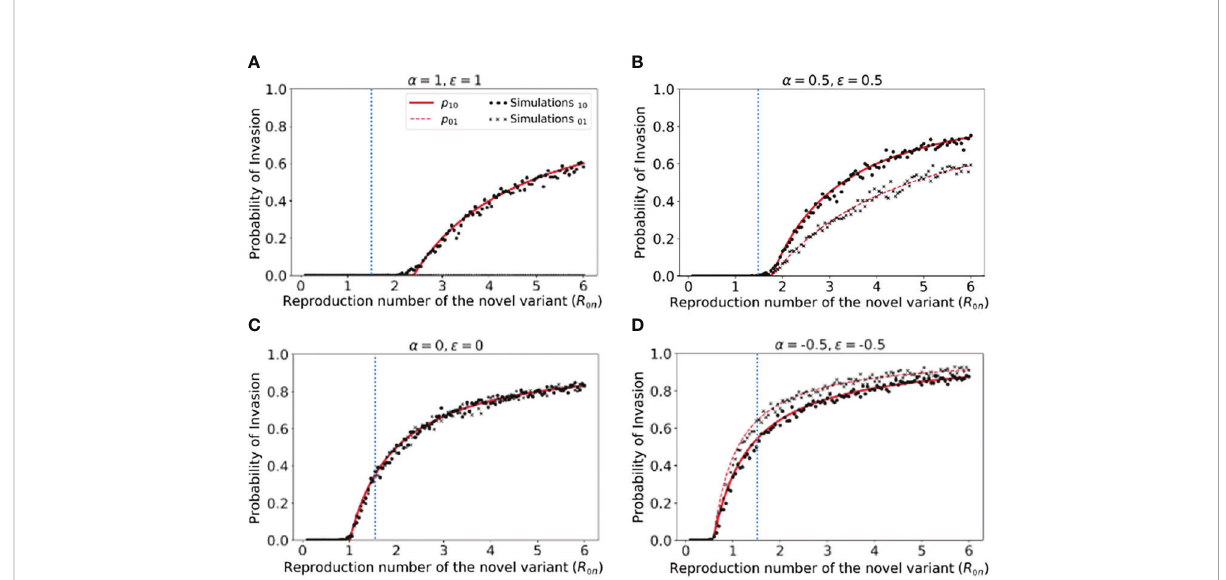
FIGURE 2 Probability of the novel variant invading the host population, starting from the introduction of a single infectious individual. (A) The probability of the novel variant invading under an assumption of perfectly protective cross-reactive immunity ( a = ϵ = 1). Results are shown both for analytic approximations of the invasion probability calculated using system of equations (3) (either starting from a single infected individual who was previously immunologically naïve (red solid) or starting from a single infected individual who was previously infected by the related virus (red dashed)) and for the invasion probability calculated using stochastic simulations (either starting from a single infected individual who was previously immunologically naïve (black dots) or starting from a single infected individual who was previously infected by the related virus (black crosses)). The vertical blue dotted line represents the reproduction number of the previously circulating virus ( R 0 p = 1.5). (B) Analogous results to panel A, but with partial protective cross-reactive immunity ( a = ϵ = 0.5). (C) Analogous results to panel A, but with no cross-reactive immunity ( a = ϵ = 0). (D) Analogous to panel A, but with cross-reactive immunity instead promoting infection with the novel variant ( a = ϵ = -0.5). In the simulations, the probability of invasion was calculated as the proportion of simulations in which the number of simultaneously infected individuals ( I n + I p ) exceeded 15 at any time (analyses for different values of this threshold are shown in Figures S2, S3, with similar results). As in Figure 1, the division of the host population between individuals who were previously immunologically naïve and those who were previously infected by the related virus was calculated based on the fi nal size equation for the previously circulating virus (equation (1)). Other parameter values used are shown in Table